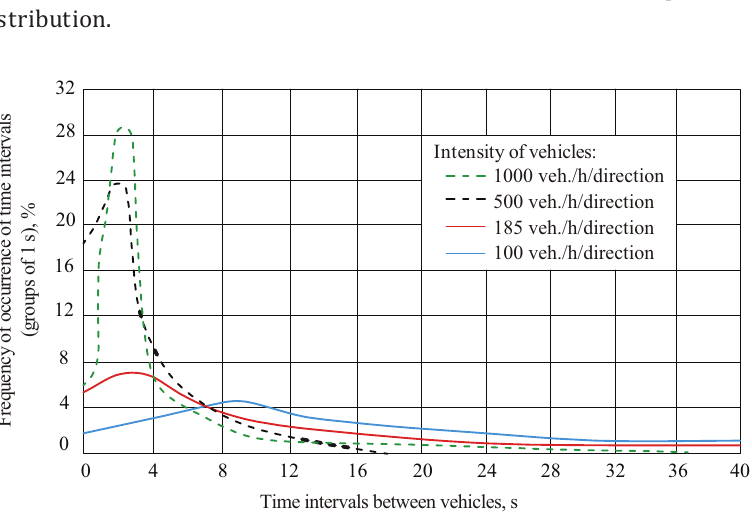
Figure 8. Distributions of time intervals for two- and four-lane road, as well as for a two-way two-lane bridge and one-way three-lane bridge according to the